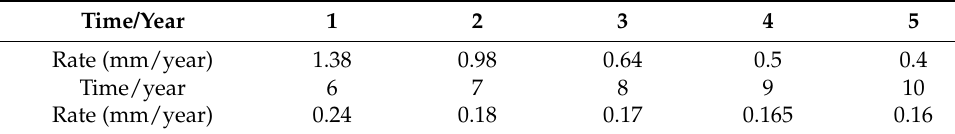
Figure 17. Settlement of each characteristic point when t = 20 years. In this paper, the hypothetical SSD coupling method was used to predict the life and performance of the deep excavated canal in the SNWDP Xichuan Section. The numerical results showed that under normal operating conditions, the canal may only subside a little after 20 years of operation. The numerical simulation in this paper is based on the coupling of the seepage field and the stress field. It is expected that the canal operates will work stably for some time in the future. 5.3. Canal Lining Damage and Crack after Long-Term Operation A numerical simulation of the evolution of the SNWDP’s deep excavated canal after 50 years of regular operation was conducted by using the SSD coupling. The canal settle- ment nephogram was obtained (Figure 18). The displacement of each characteristic point is shown in Figure 19. Compared with the settlement nephogram after 20 years of opera- tion, the settlement is insignificant and remains stable. Figure 18. Canal settlement nephogram when t = 50 years.